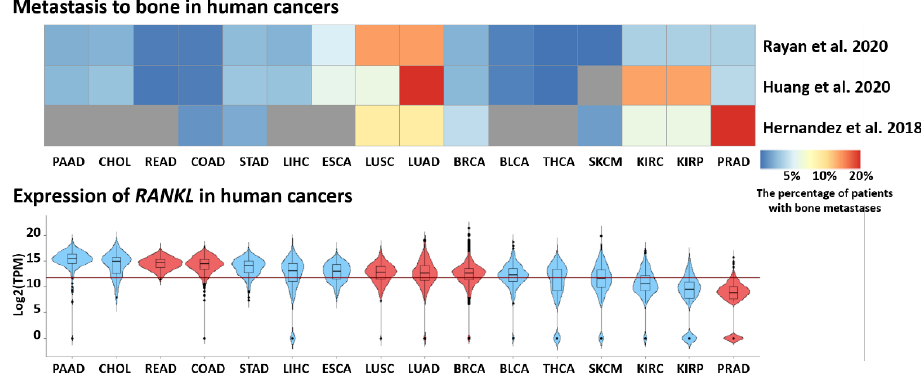
Figure 2. Bone metastasis and RANKL expression in human cancers. The upper panel shows the percentage of patients with bone metastasis at the cancer diagnosis time. Studies utilized Surveillance, Epidemiology and End Results (SEER) and Oncology Services Comprehensive Electronic Records (OSCER) databases [139 – 141]. The percentage of patients is presented as a heatmap with the color intensity corresponding to higher percentage of cases. Missing data for selected cancer types are in gray. The lower panel shows the expression of RANKL ( TNFSF11 ) in selected primary tumors. Violin plots show log2-transformed expression of RANKL gene in selected cancer types. Cancers with the confirmed role of RANKL – RANK signaling in metastases are marked in red. The horizontal red line shows the median expression for all cancers in the dataset. Abbreviations: PAAD — pan-